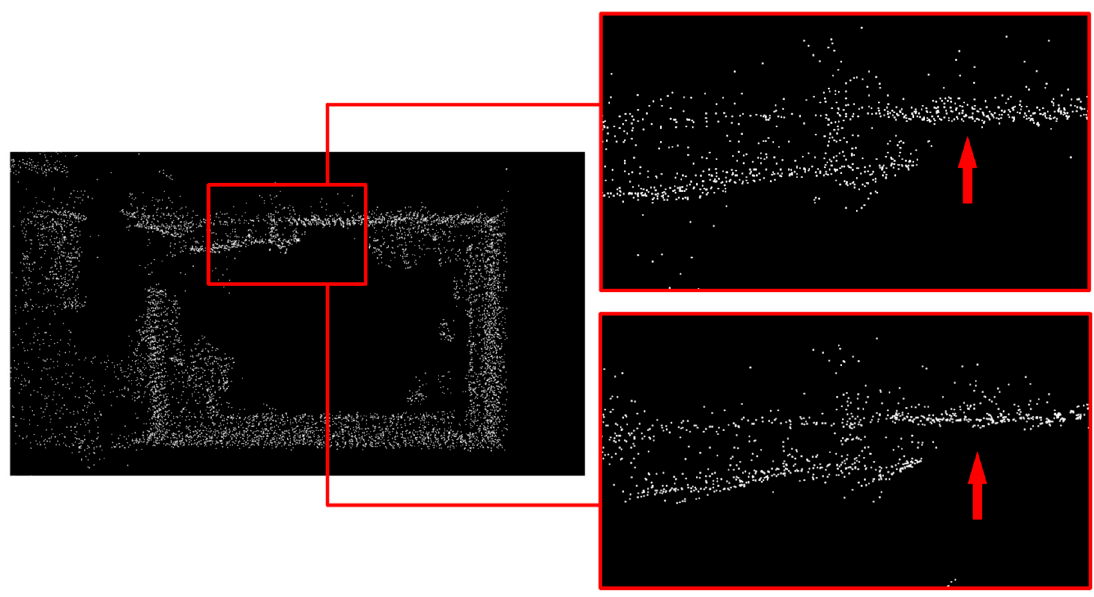
Figure 12. Scanned room in the indoor experiment.